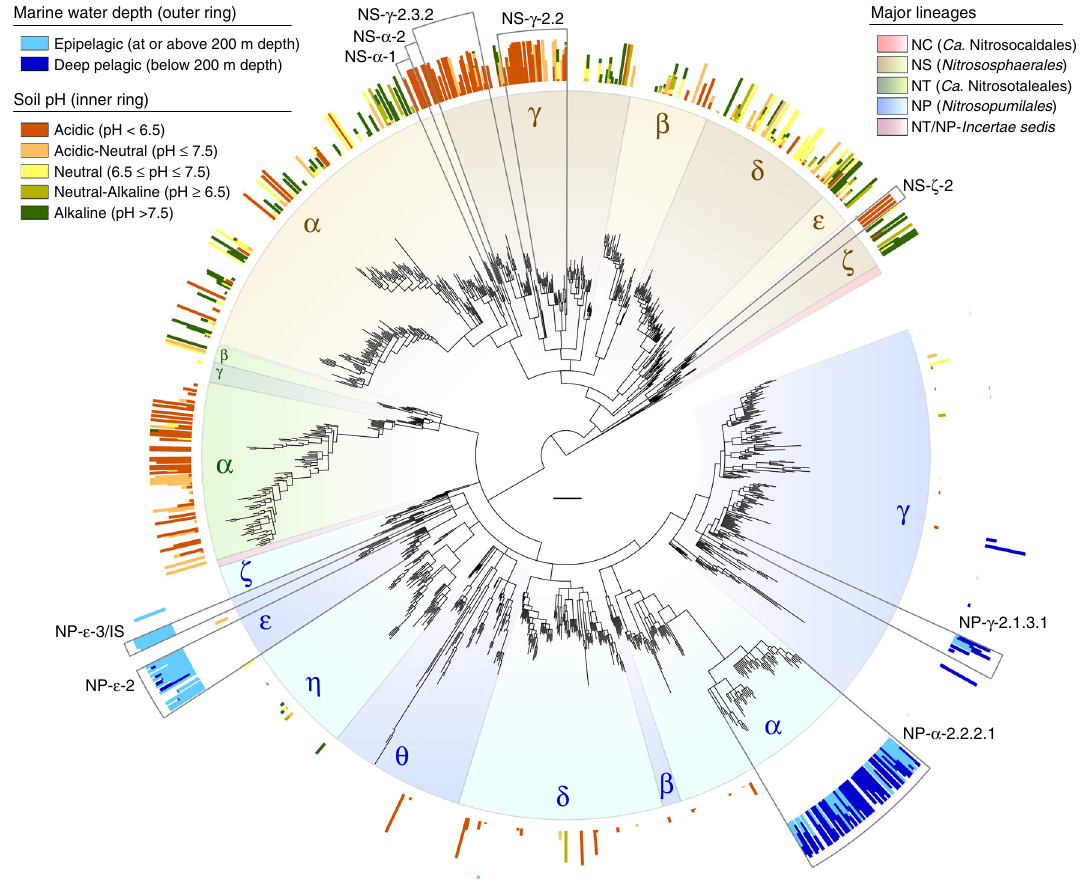
Fig. 7 Phylogenetic distribution of archaeal amoA genes according to soil pH and marine water depth. The occurrence of amoA genes in distinct water column zones (2757 sequences) and soils with different pH (4754 sequences) is represented as fraction of sequences in each OTU (96% sequence identity). Fractions were calculated in relation to total number of sequences assigned to a niche/habitat within the same category level, and excluding those only assigned to the broader category above (e.g., fraction of each seawater depth among all sequences that could be assigned to a depth category). Subclades speci fi ed in the main text are indicated by grey lines. The scale bar represents 0.1 substitutions per nucleotide position. The absolute and relative phylogenetic/taxonomic distribution of sequences from these habitats are also available in interactive Krona 47 charts (Supplementary Data 6, 9). See legend of Fig. 1 for tree